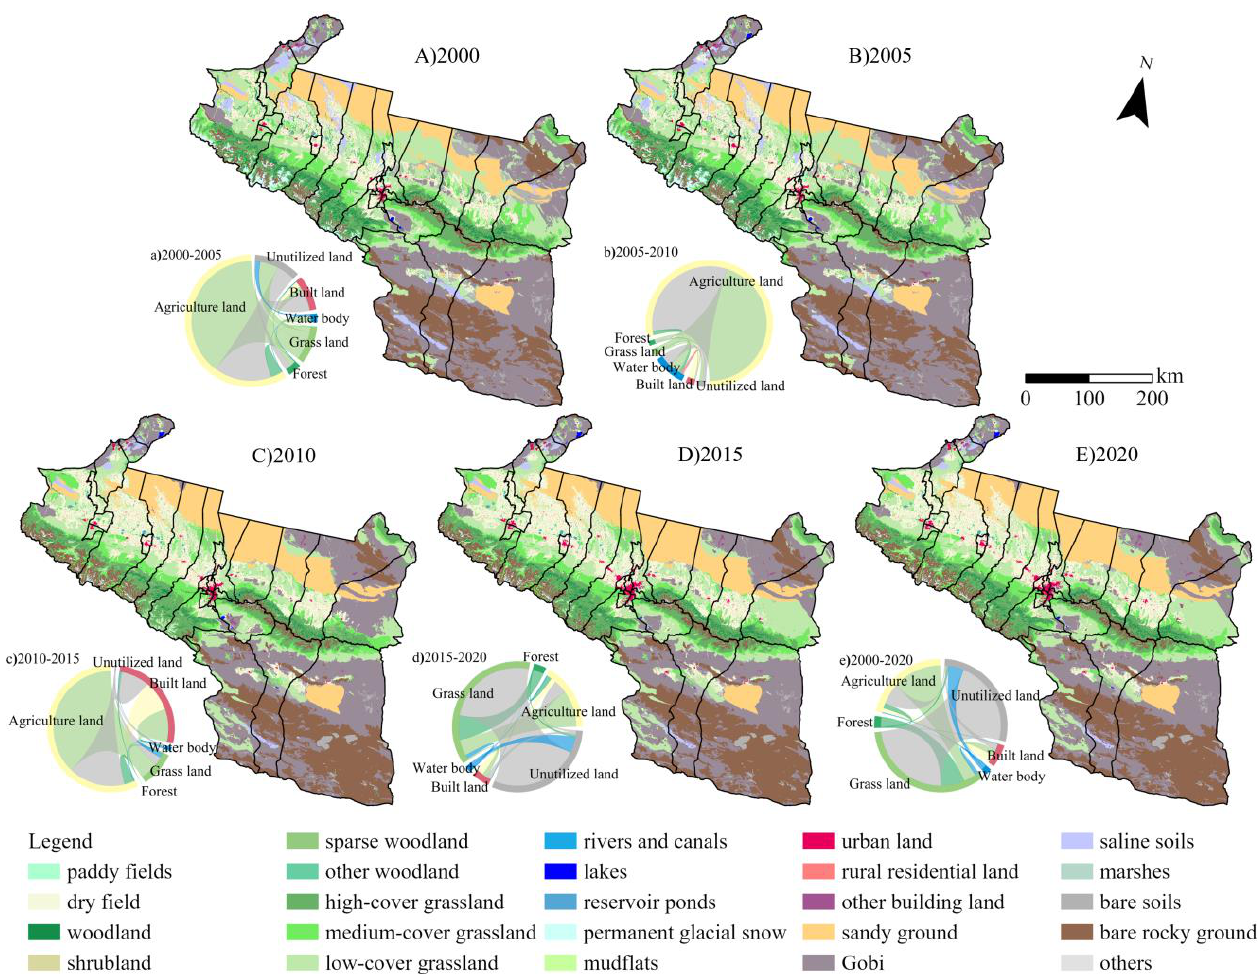
Figure 3. Level 2 LULC type map and proportional chord chart of level1 LULC type transformation in the UANSTM.